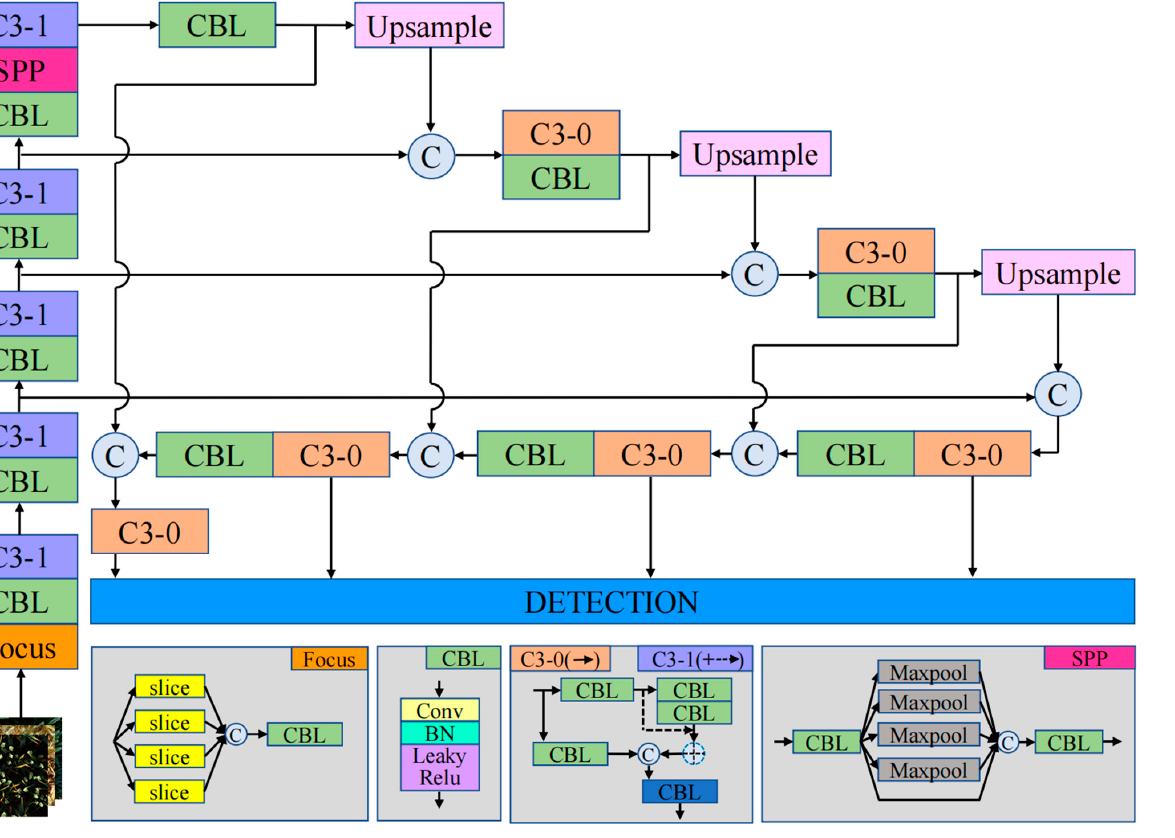
Figure 11. The final modified network structure .